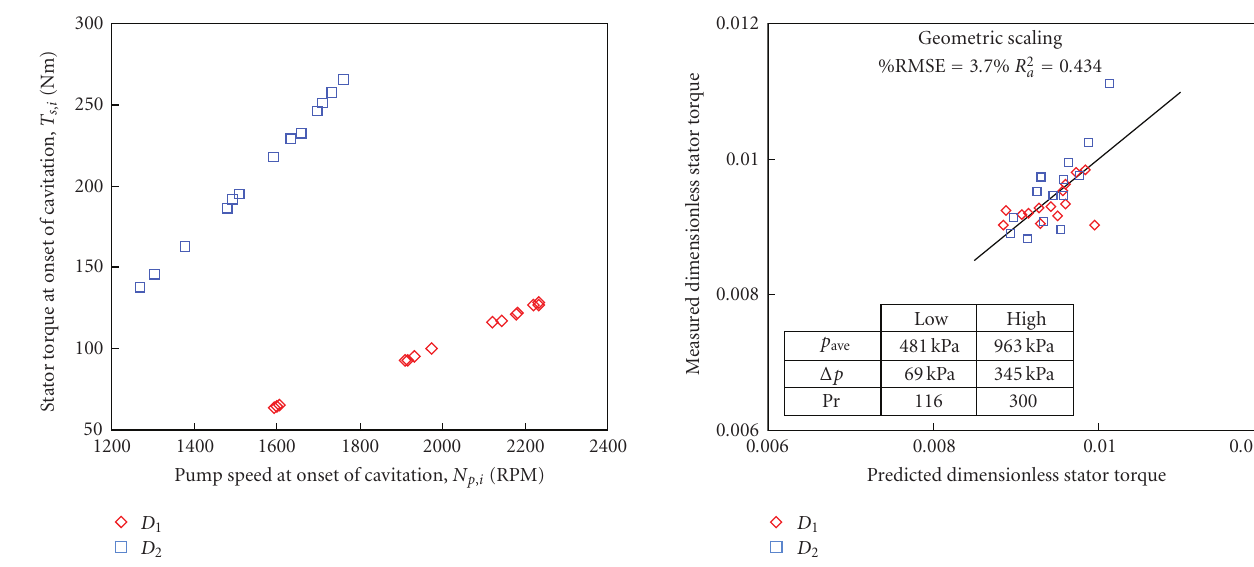
Figure 9: Dimensionless power product model fit on dimension- less stator torque for torque converters of exact geometric scaling, over range of operating points in Table 2.